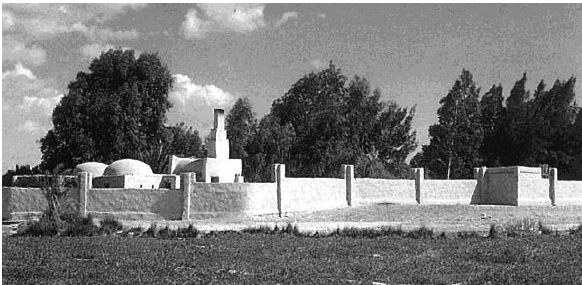
Figure 16. Porret’s house in Tunis and the pottery workshop, 1990 © Musée De Saint -Amande-Les-Eaux, Evelyne Porret - Michel Pastore, Potiers de France en Égypte - 1970-1990 , 1990. But at the same time, local peasants who had to travel and work for years in the oil rich Arab gulf states for economic reasons during the 1970s and 1980s, once back to Tunis, decided to replace the mud brick houses with concrete constructions. The fact being the poorer the family is the longer the vernacular survives.